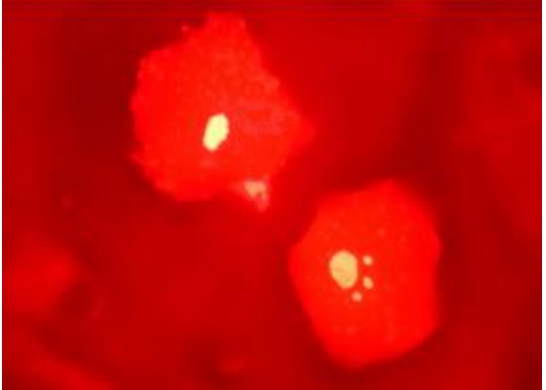
Figure 2. MN test: image of buccal mucosa cells with and without MN observed through fluores- cence microscopy.